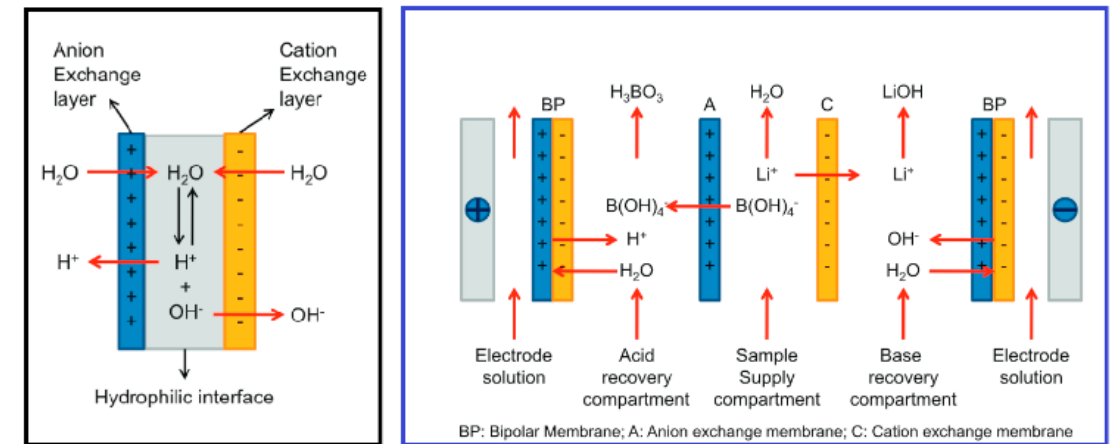
Figure 15. Schematic Diagram of Bipolar and Ion − exchange Membrane for Lithium and Boron Harvesting [95].